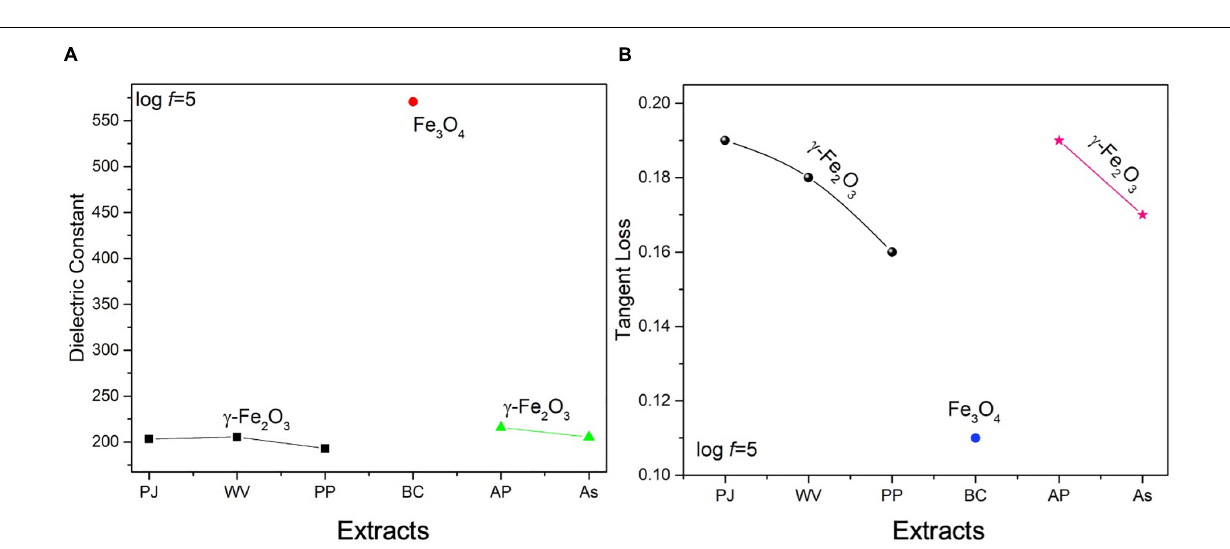
Frontiers in Microbiology |